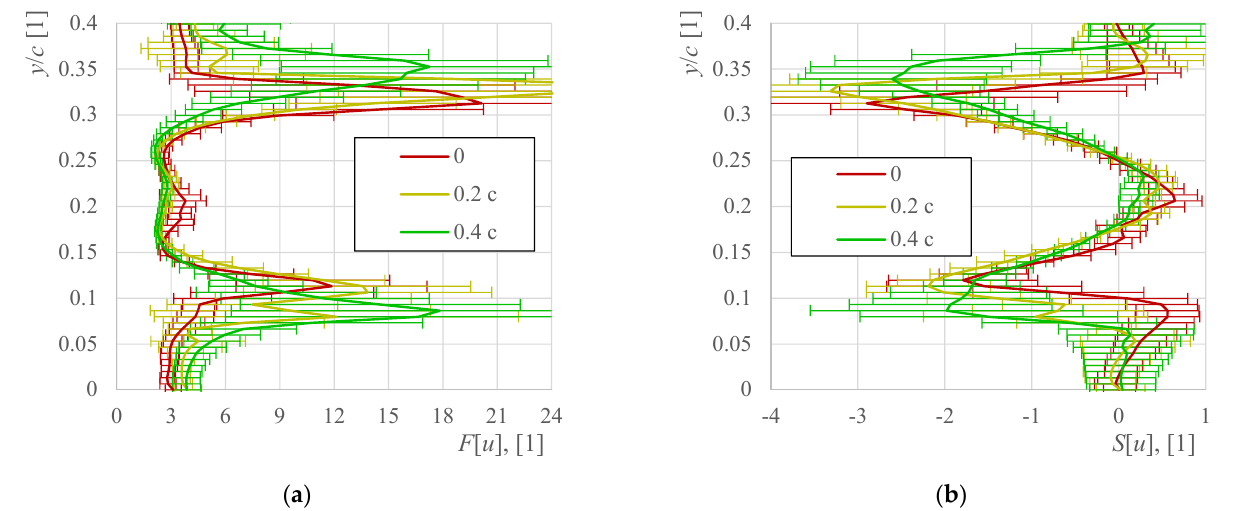
Figure 10. ( a ) Profiles of flatness coefficient of the stream-wise velocity component. ( b ) Profiles of the skewness of stream- wise velocity component at depicted distance past the trailing edge distinguished via colors: we apologize to readers with grayscale printer.